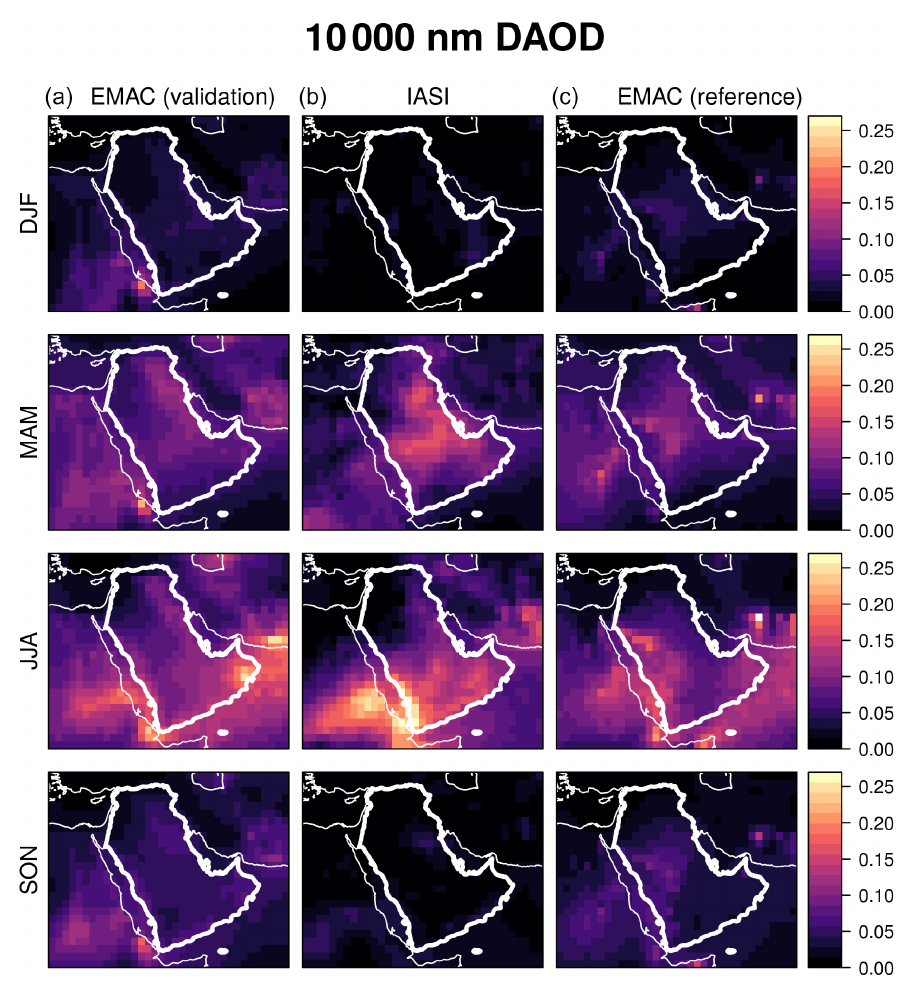
Figure 14. Seasonal 10µm DAOD over the Middle East in 2011 observed by IASI (b) and simulated by EMAC with (“validation”, a ) and without (“reference”, c ) revision of the dust emission scheme. Each row shows the 3-month averages over the periods (from top to bottom) DJF (December, January, February), MAM (March, April, May), JJA (June, July, August) and SON (September, October, November). Es- pecially throughout the white-bounded region encompassing the Arabian Peninsula including Iraq, Syria and Jordan, the DAOD distribution obtained with the revised dust emissions agrees significantly better with the IASI observations (see Fig. S7 in the